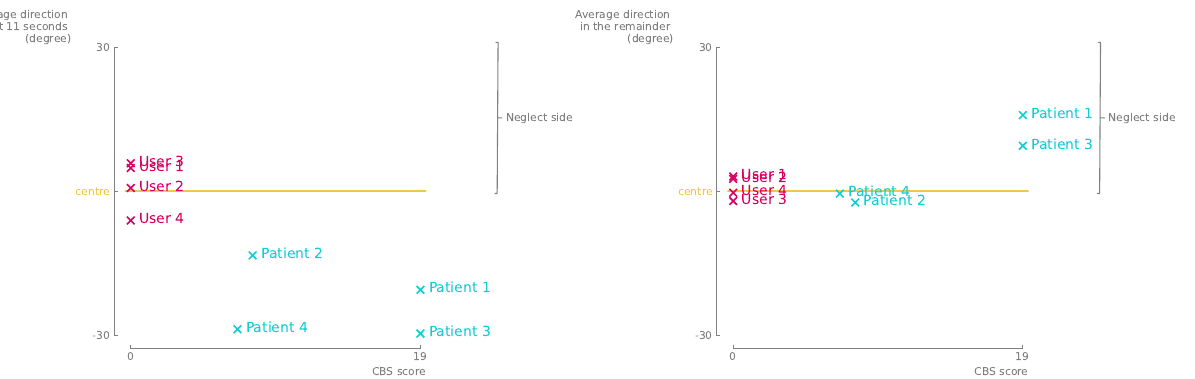
Figure 13. ( Left ) Users with a higher CBS score indicate a higher bias towards their non-neglected side compared to the users with a CBS score of 0. Within the patient sample, no significant difference in head direction can be observed based on the CBS score for the first 11 s. ( Right ) The CBS scores of all participants are plotted against the average head direction during the remainder of the Assessment . These show that the bias of the head direction has shifted towards the non-neglected side for users with a higher CBS score.